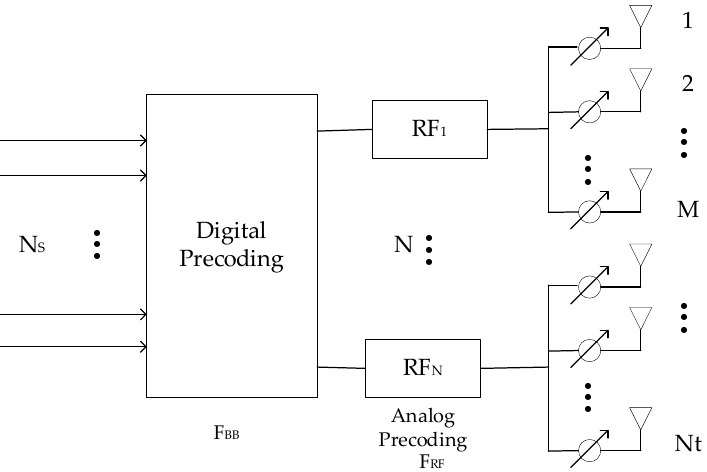
Figure 1. Hybrid precoding for mm-Wave massive MIMO systems based on partially con- nected architecture.